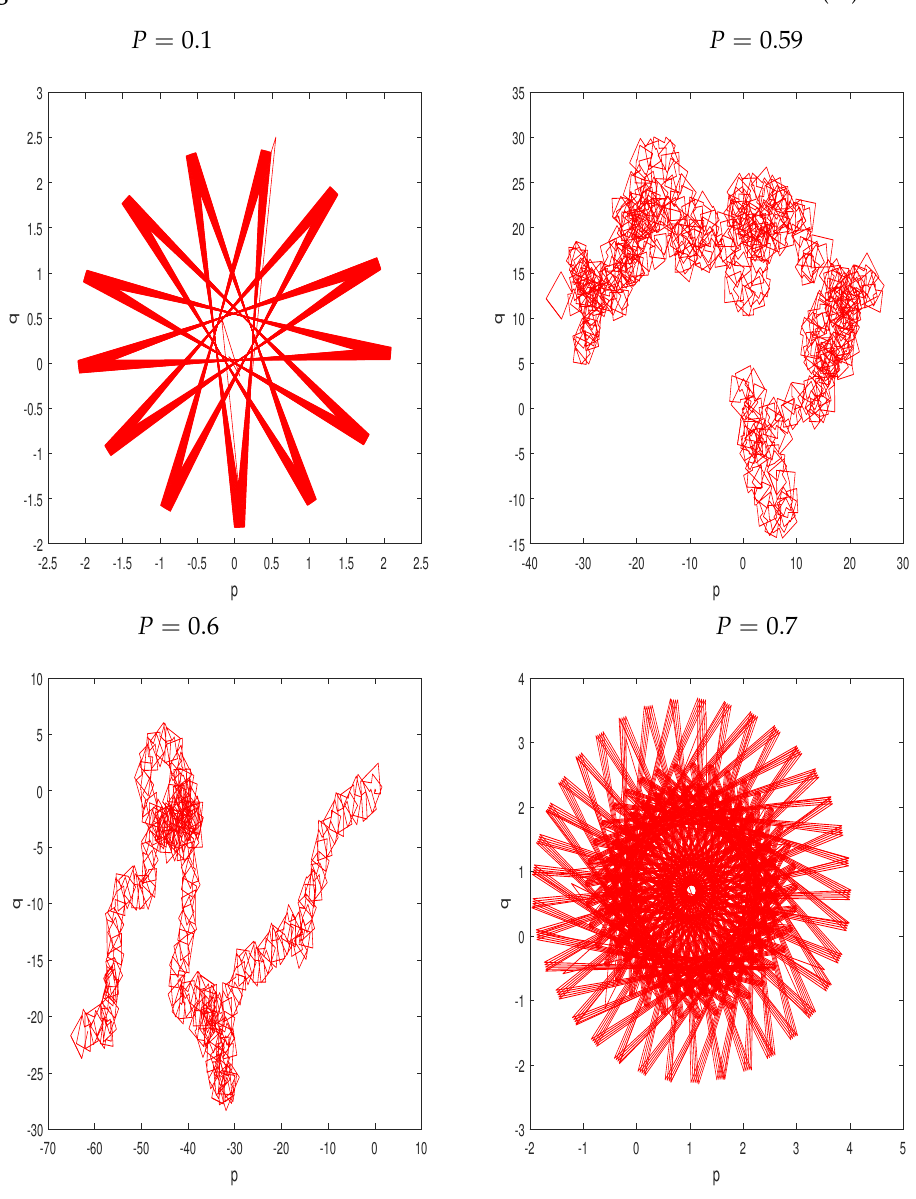
Figure 7. The plot of p versus q for the D.T.H.N.N with incommensurate fractional V.O (10) for different values of the system parameter P .